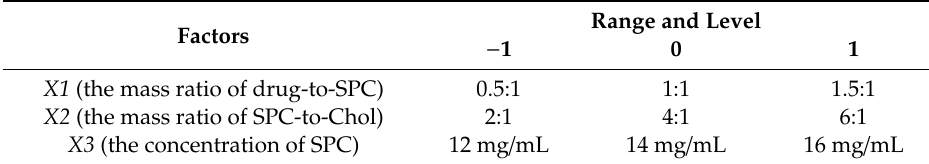
Table 6. Levels of factors used in Box–Behnken design (BBD).